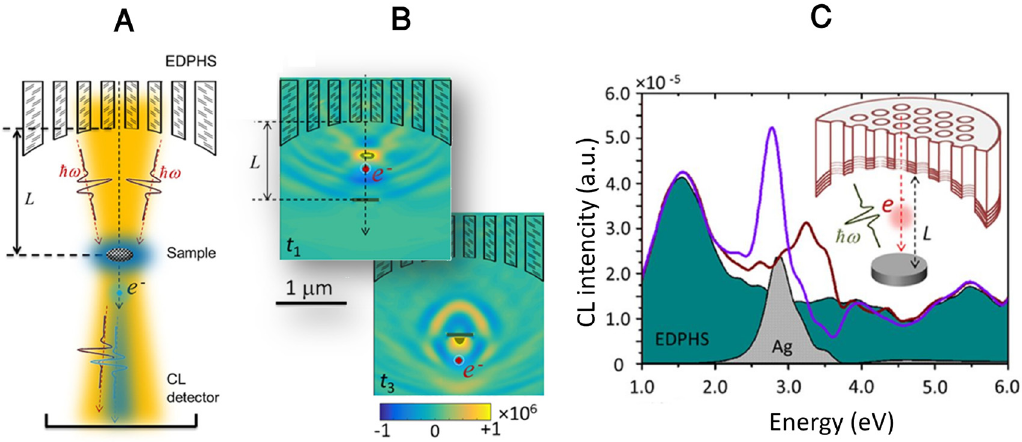
Figure14: (A) Thesetup iscomposedof asimulatedEDPHS,which oninteractionwith aswiftelectrongeneratesphotonsthatare scatteredin a unidirectional way toward the sample and focused on it. (B) The EDPHS excitation interferes with the electron-induced CL emission of the sample, either destructively or constructively, depending on the distance L between the sample and EDPHS. The sample is positioned at the focal point of the EDPHS. (C) CL spectra for an isolated EDPHS (teal shadowed region) and also a sample coupled to the EDPHS at distances L = 1.0 μ m between the sample and EDPHS for silver disc [16]. CL, cathodoluminescence; EDPHS, electron-driven photon